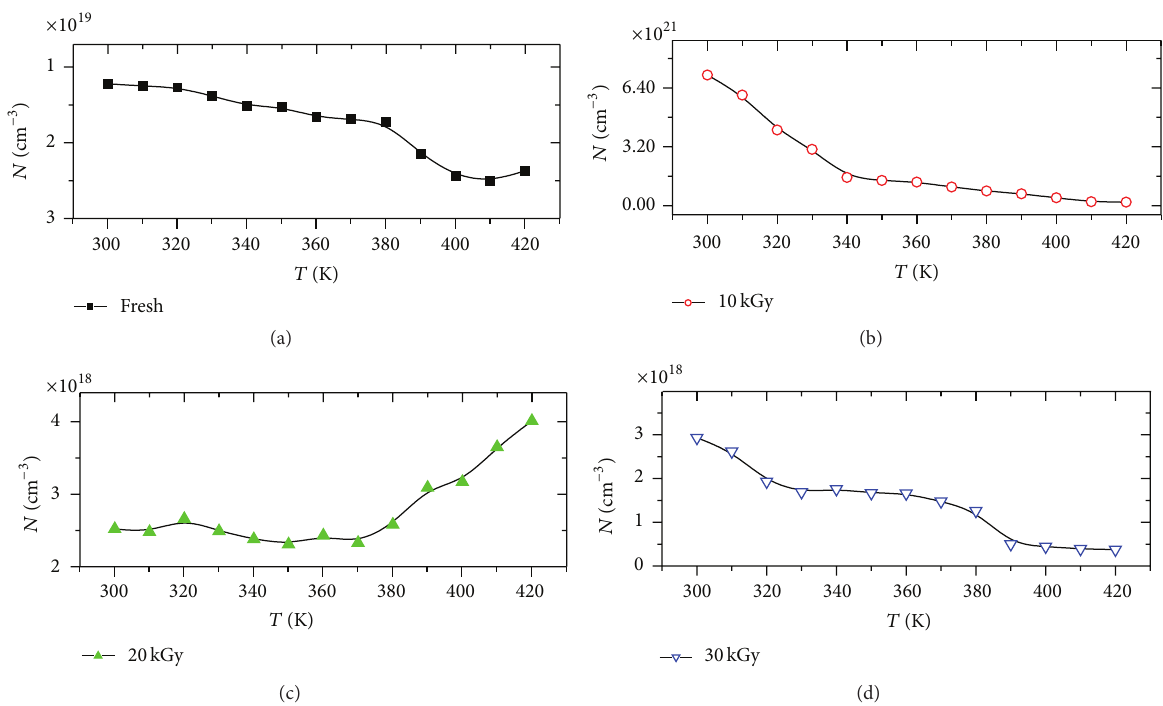
Figure 3: Temperature dependence of carrier concentration, 𝑁 , for the investigated CdS thin film (a) before and (b–d) after 𝛾 -irradiation with different doses.